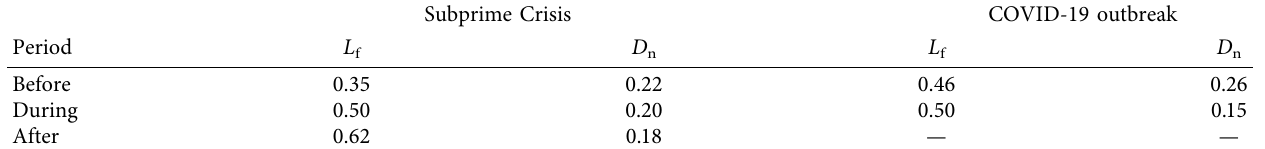
Table 3: Descriptive parameters of the structure of the minimum spanning